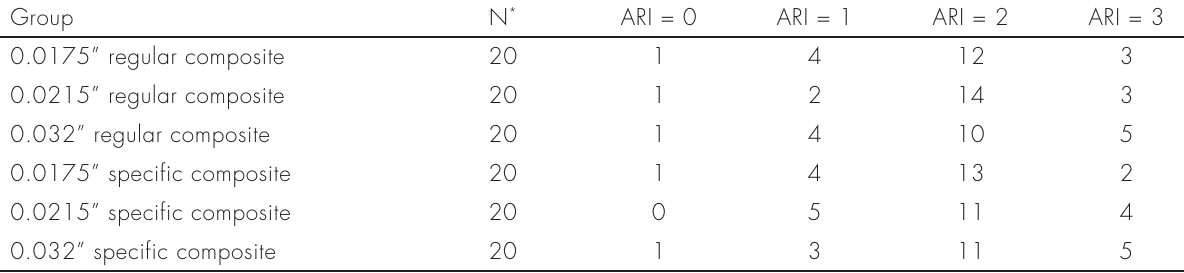
Table I. Adhesive remnant index (ARI) score frequency according to groups.